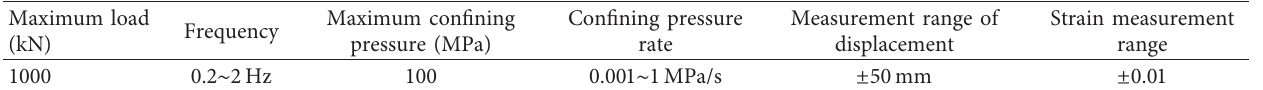
Table 1: Parameters of RMT-150C rock